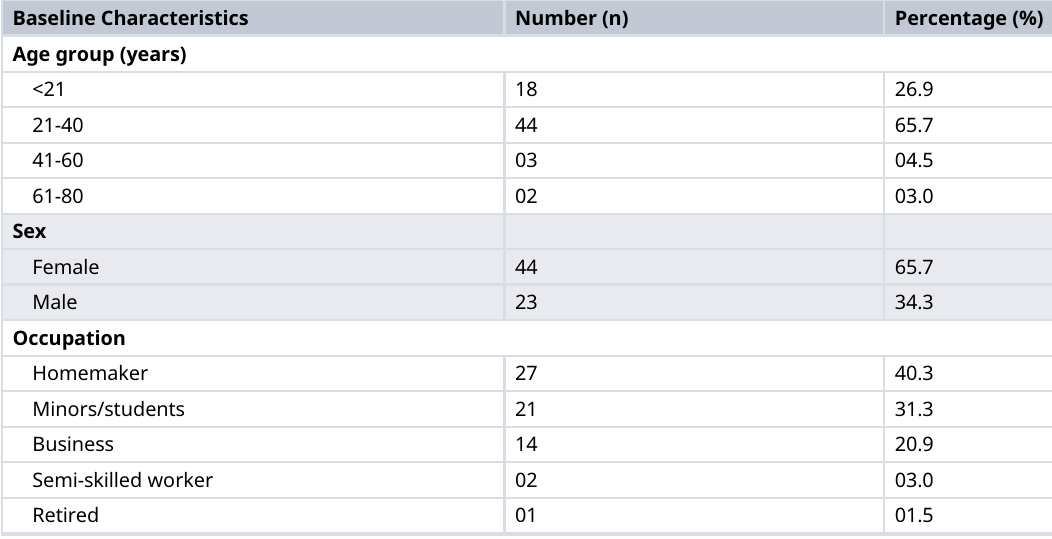
Table 1. Baseline characteristics of Kikuchi Fujimoto disease patients